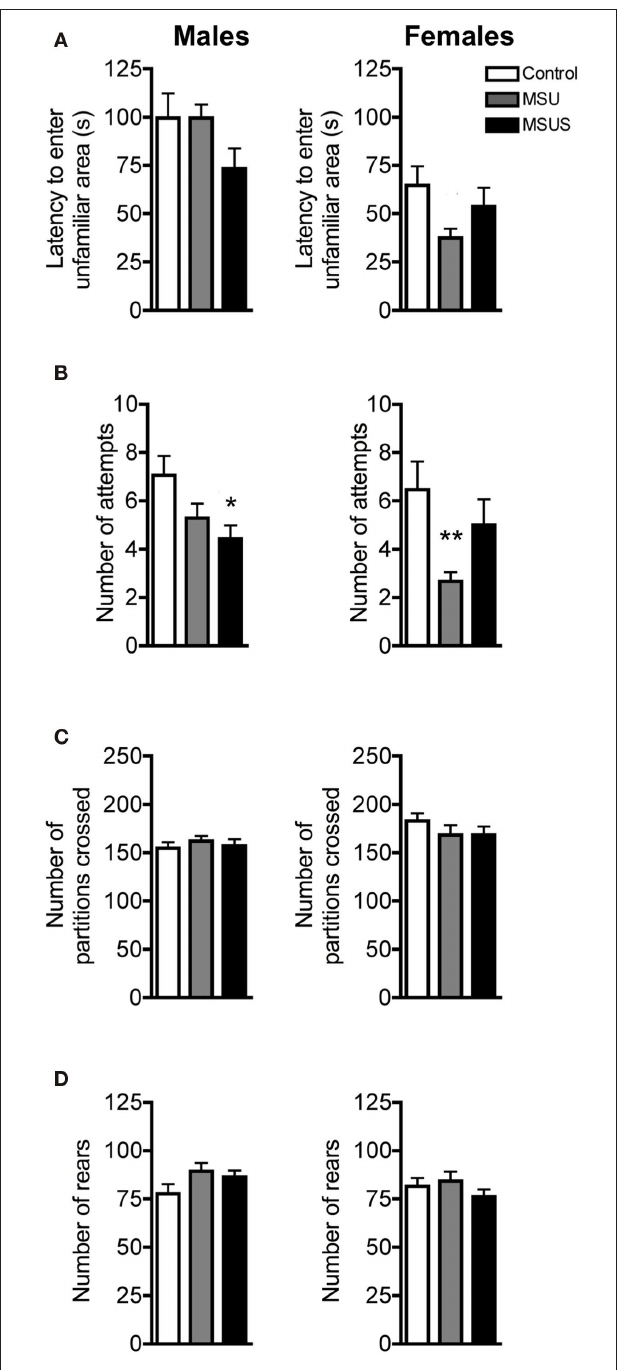
FigUrE 2 | Behavior in F 1 control, MSU, and MSUS mice in the free exploratory paradigm. (A) F 1 MSUS males (left) and F 1 MSU females (right) showed a tendency to enter the unfamiliar partitions sooner than controls. (B) F 1 MSUS males (left) and F 1 MSU females (right) made fewer attempts to enter the unfamiliar partitions than control mice. (C,D) F 1 MSU and MSUS mice had (C) a number of partition crossings and (D) rears comparable to that in control mice. Males: MSU, n = 14, MSUS, n = 14, control, n = 17; females: MSU, n = 12, MSUS, n = 16, control, n = 13. * p < 0.05, ** p < 0.01 compared to control mice. Bar graphs represent mean values ±